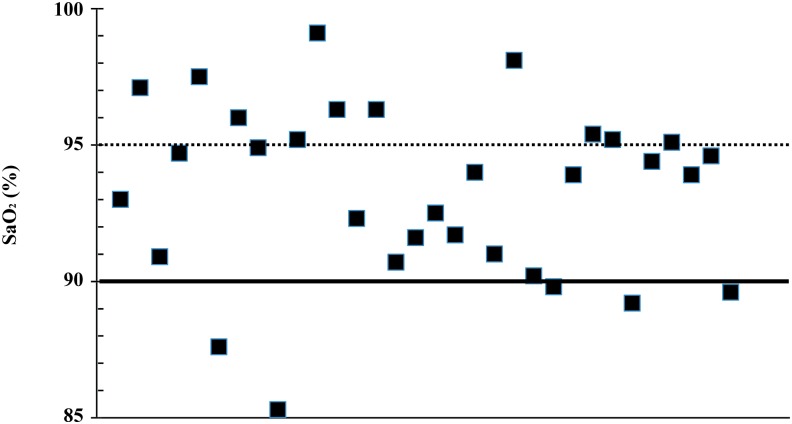
SaO2 (oxyhemoglobin saturation) data of 32 patients obtained immediately after arterial catheter placement.Before right heart catheterization, each patient had an arterial catheter placed into their radial artery ipsilateral to the pulse oximeter probes. Arterial blood was sampled, and the SaO2 was measured by blood gas analyzer (ABL 825). Closed squares indicate initial SaO2 values of 32 patients enrolled in this study.